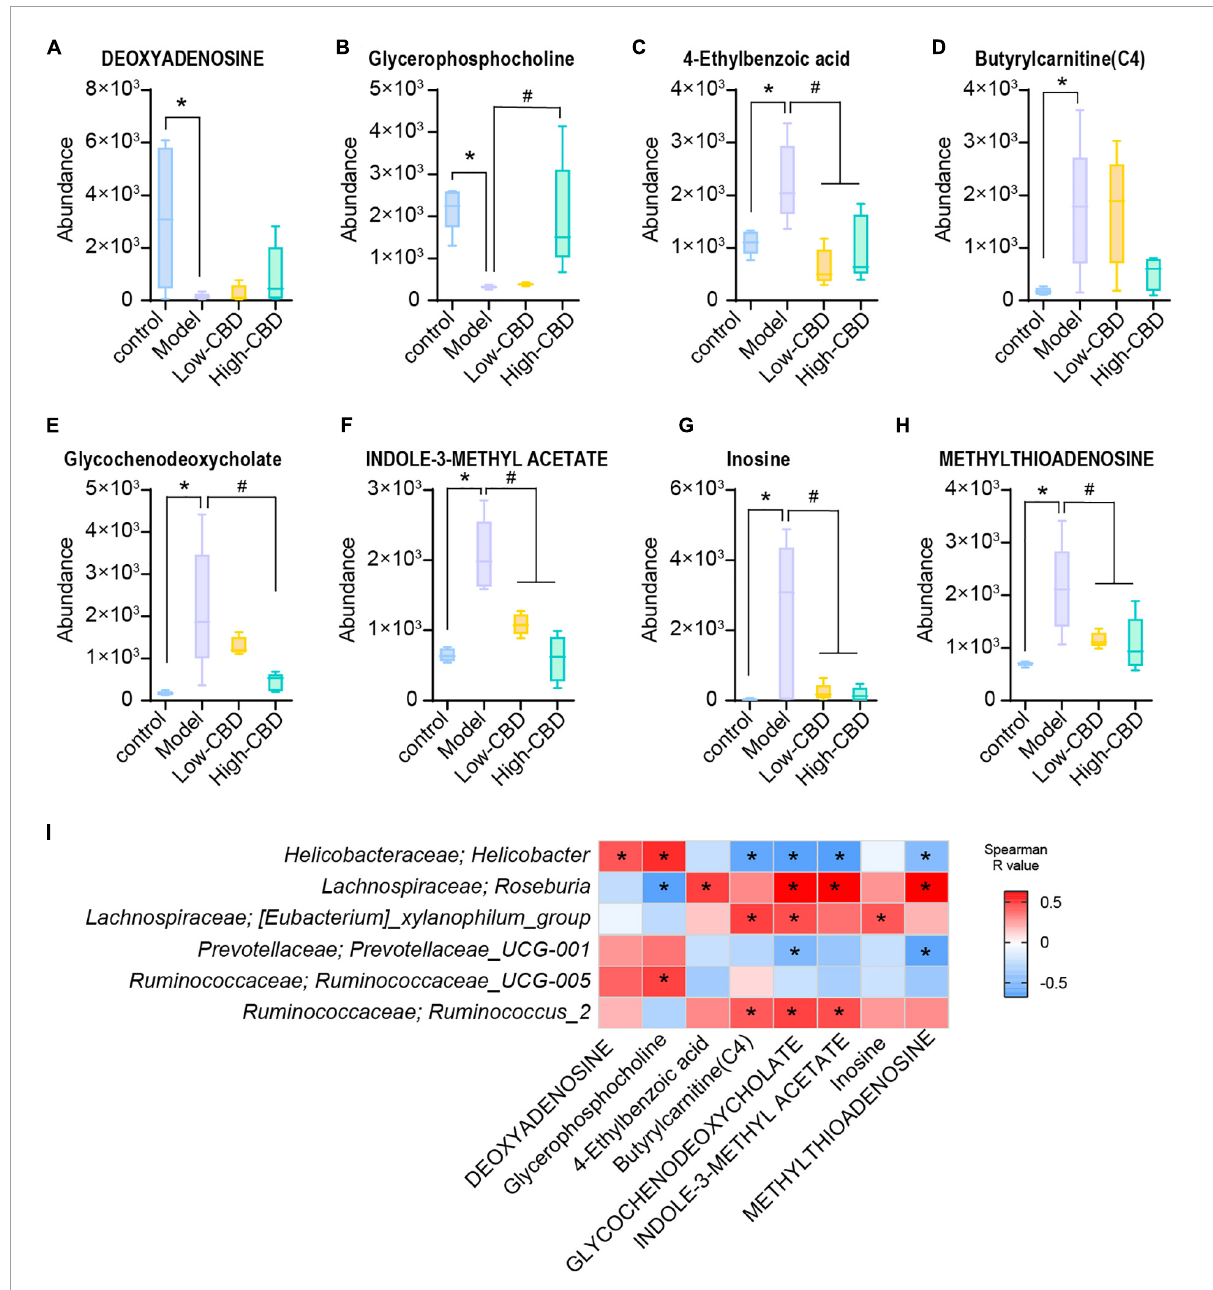
FIGURE9 Effects of cannabidiol (CBD) on the changes of the levels of metabolites in rats with Epilepsy. (A-H) Relative abundance of deoxyadenosing, glycerophosphocholine, 4-ethylbenzoic acid, butyrylcarnitine (C4), glycochenodeoxycholate, indole-3-methyl acetate, inosine, and methylthioadenosine. *Indicates a significant difference compared with the control group and #indicates a significant difference compared with the model group, P < 0.05. (I) The relationship between the gut bacteria and the different metabolites. Blue represents negative correlation and red represents positive correlation. The larger the absolute value of R, the stronger the correlation; *indicates significant